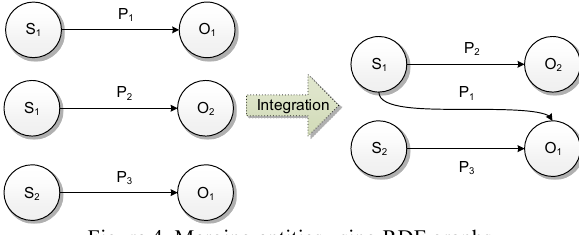
Figure 4. Merging entities using RDF